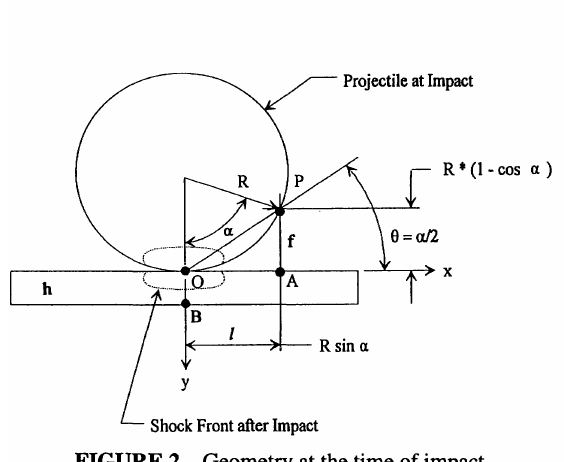
FIGURE 2 Geometry at the time of